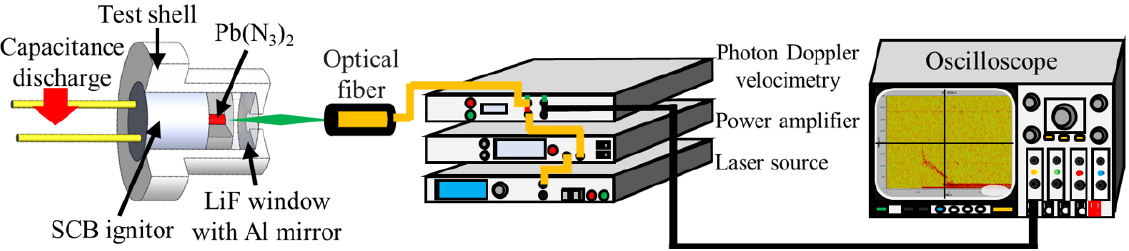
Figure 3. Schematic of test sample and PDV system.